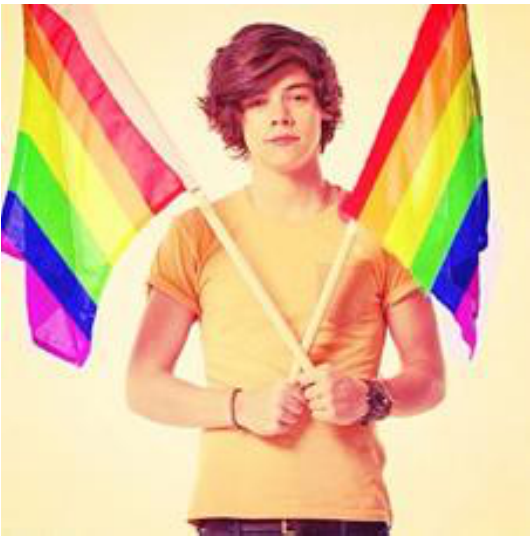
Figure 1. Image from [22]. The polarity assigned to this image mostly depends on the circumstances and the cultural